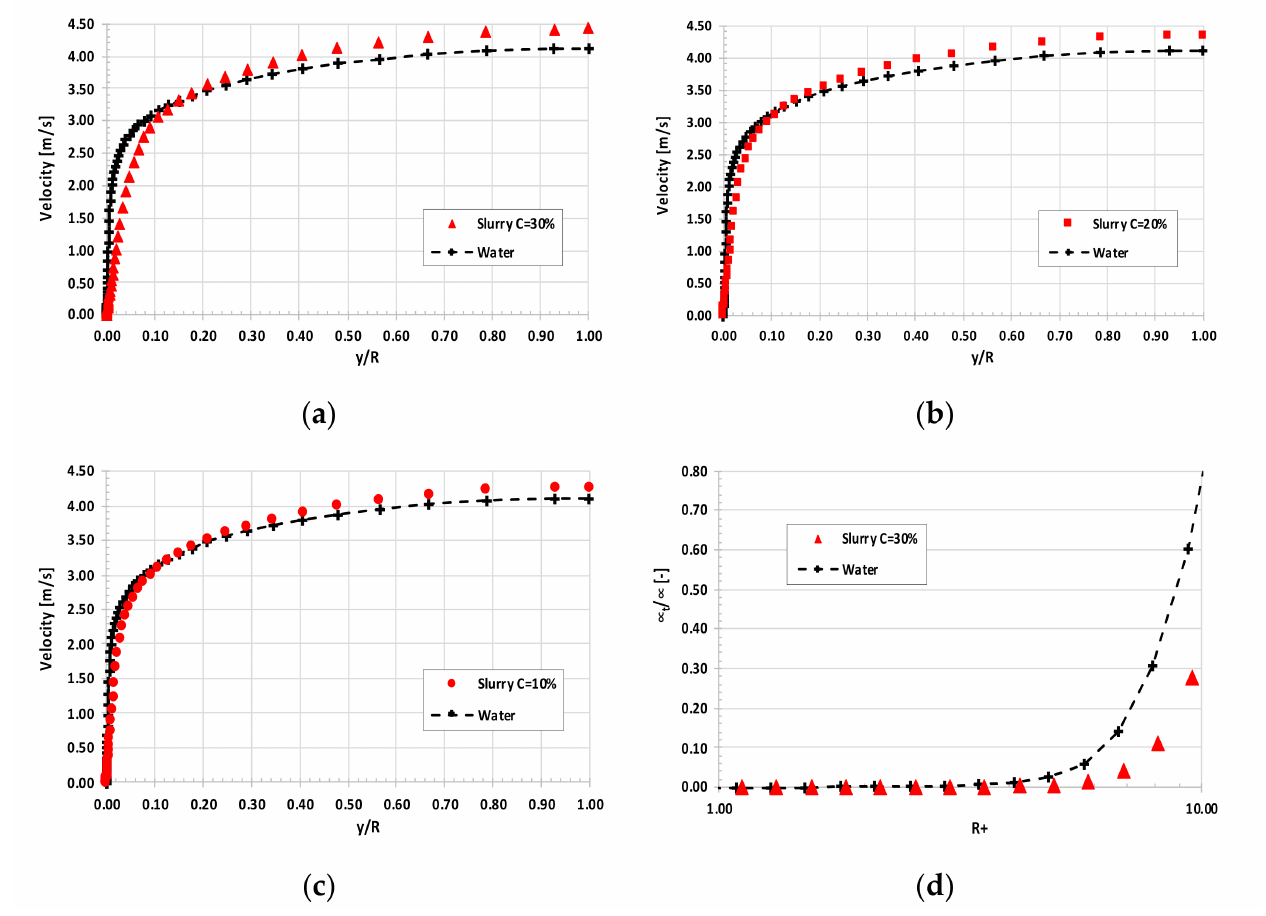
Figure 5. ( a ) Comparison of velocity profiles for slurry and water; C = 30%; U b = 3.5 m/s; q = − 500 W/m. ( b ) Comparison of velocity profiles for slurry and water; C = 20%; U b = 3.5 m/s; q = − 500 W/m. ( c ) Comparison of velocity profiles for slurry and water; C = 10%; U b = 3.50 m/s; q = − 500 W/m; ( d ) Comparison of logarithmic profiles of dimensionless turbulent stresses for slurry and water; C = 30%; U b = 3.50 m/s; q = − 500